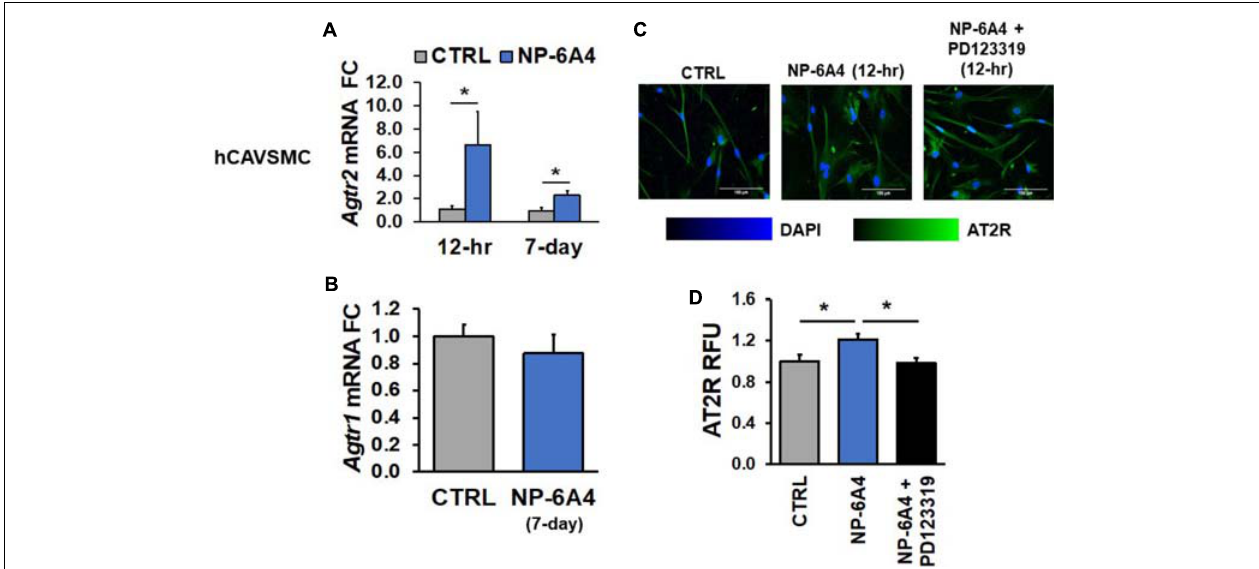
FIGURE 1 | NP-6A4 increased Agtr2 mRNA and AT2R protein expression in hCAVSMC. (A) 1 µ M NP-6A4 for 12-h and 7-day increased Agtr2 mRNA expression. (B) No change in Agtr1 mRNA was detected after 1 µ M NP-6A4 for 7-days. n = at least three biological replicates and PCR replicates, respectively, for these experiment. (C) Representative images of hCAVSMCs treated with 1 µ M NP-6A4 for 12-h. Blue indicates DAPI stained nuclei and green AT2R. Merged images are shown for all experimental conditions. (D) Quantification of relative fluorescent units (RFU) shows increased expression of AT2R protein after 1 µ M NP-6A4 treatment for 12-h and 20 µ M PD123319 prevented this increase. Immunofluorescent experiments consisted of quantification of > 50 cells from triplicates per experiment. ∗ Indicates p < 0.05 using One-way ANOVA. hCAVSMC, human coronary artery vascular smooth muscle cell; FC, fold change.